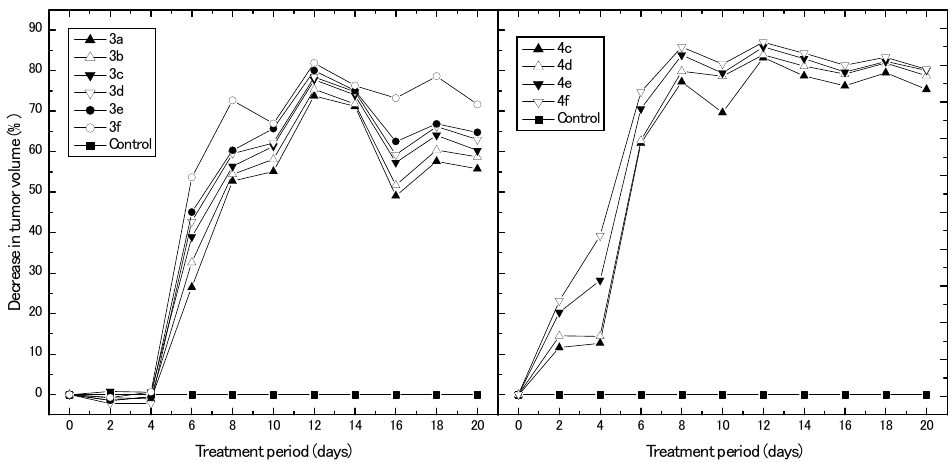
Figure 4. IC 50 values obtained for different synthesized compounds against MCF-7.